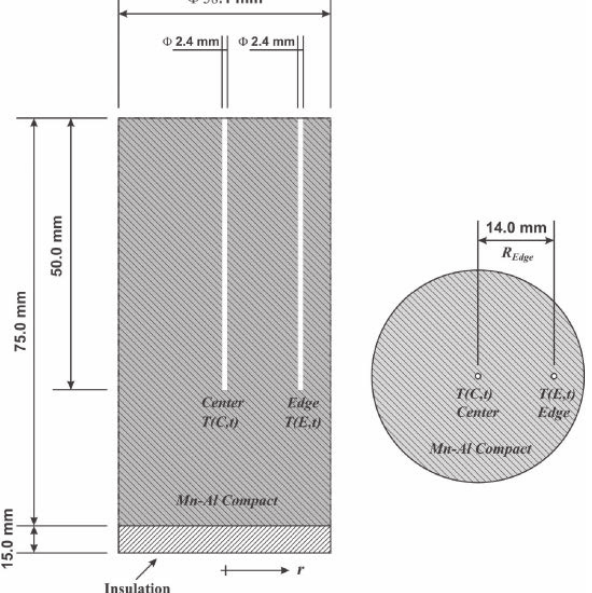
Fig. 1: Dimensional details of manufactured Mn-Al cylindrical compact specimens.